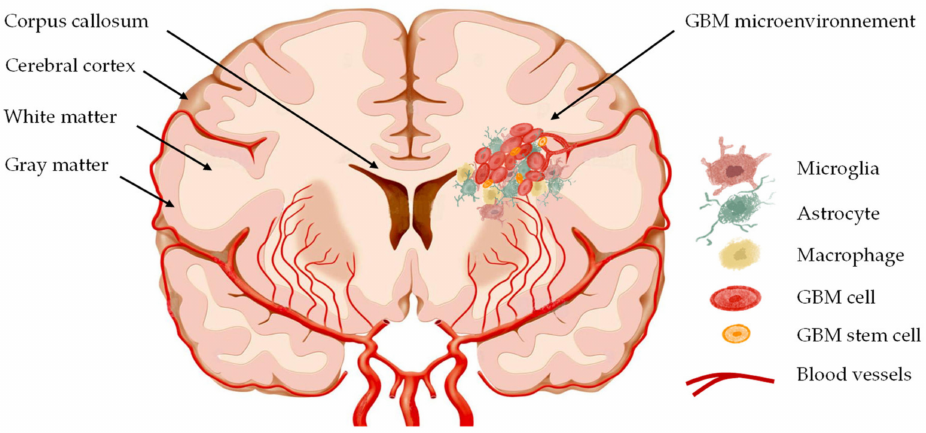
Figure 1. Schematic illustration of